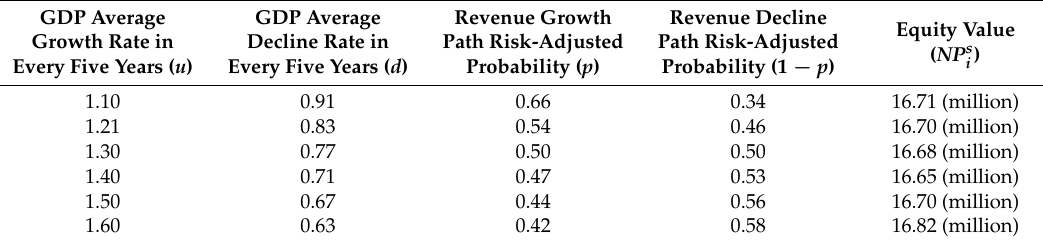
Table 3. The influence of the GDP average growth rate in every five years u on equity